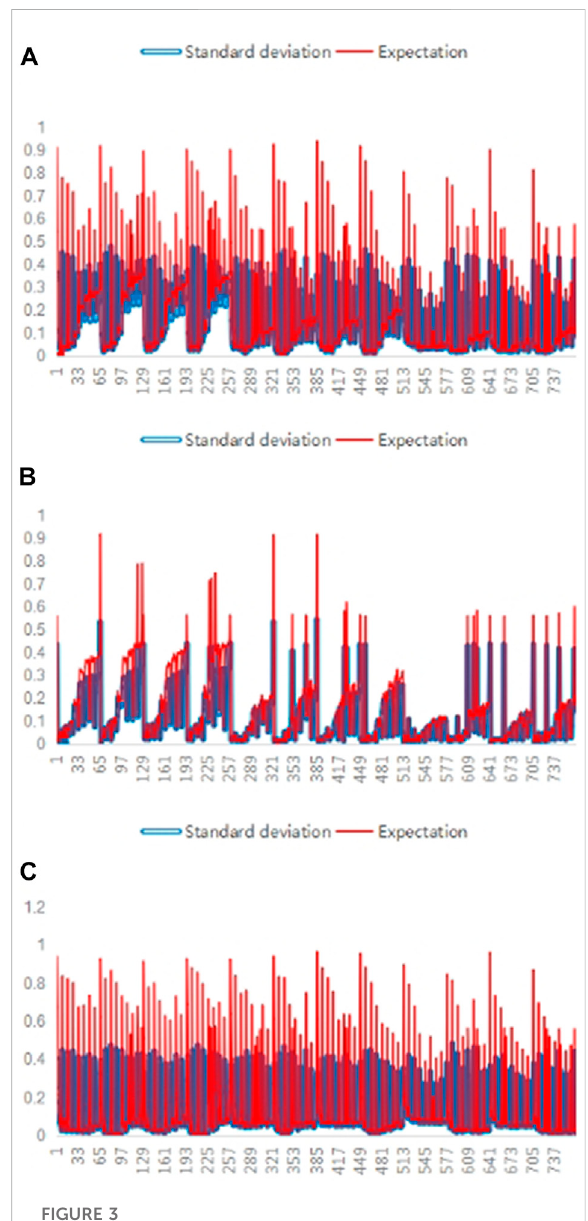
FIGURE 3 Differencesbetweenthevarious SVcallers.In (A) , (B) , and (C) , the values of the three performance evaluation metrics, i.e., f-measure, precision, and recall, were calculated for each of the fi ve callers on 768 long-read sequencing datasets. For each dataset, expectation values for one of the three performance evaluationmetricswerecalculatedandshownwithredlines,while thestandarddeviationvaluesareshownwithbluelinesinthethree sub fi gures, where the abscissa denotes the number of the long- read sequencing datasets and the ordinate denotes the corresponding performance evaluation metric